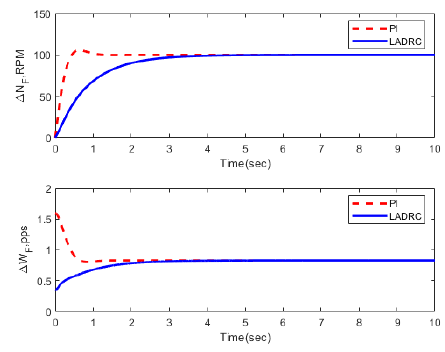
Figure 13. Step response of FC04.